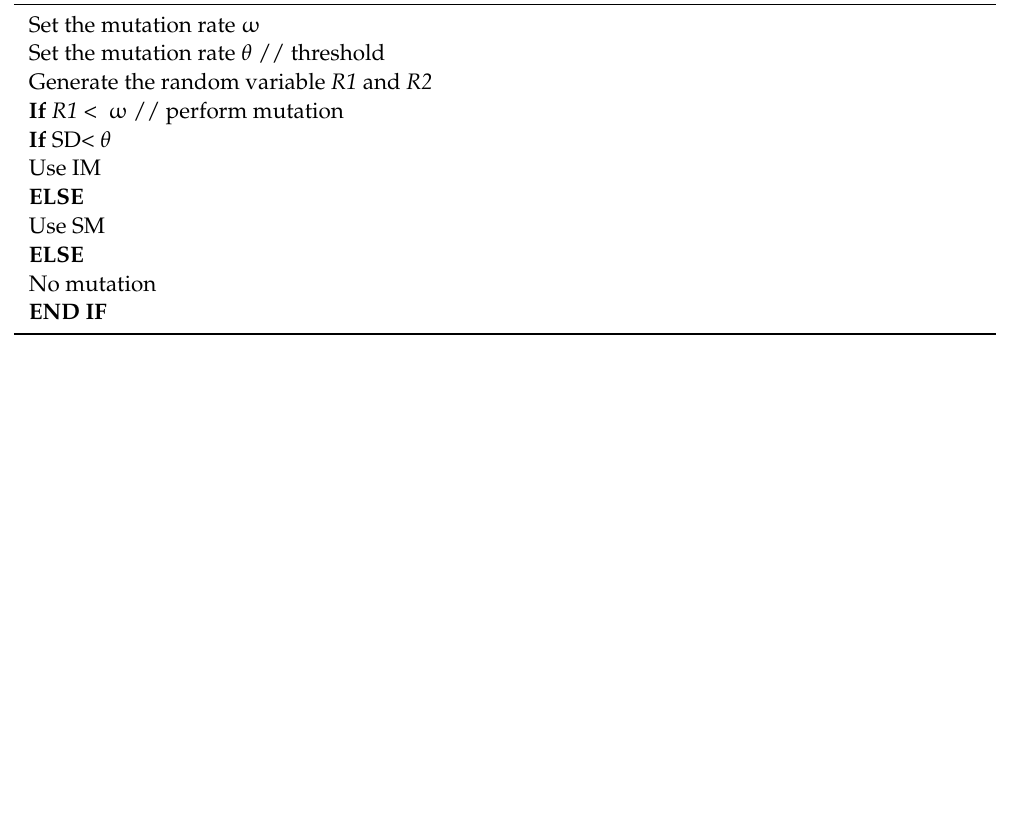
Algorithm A2. The psudo-code of the mutation(